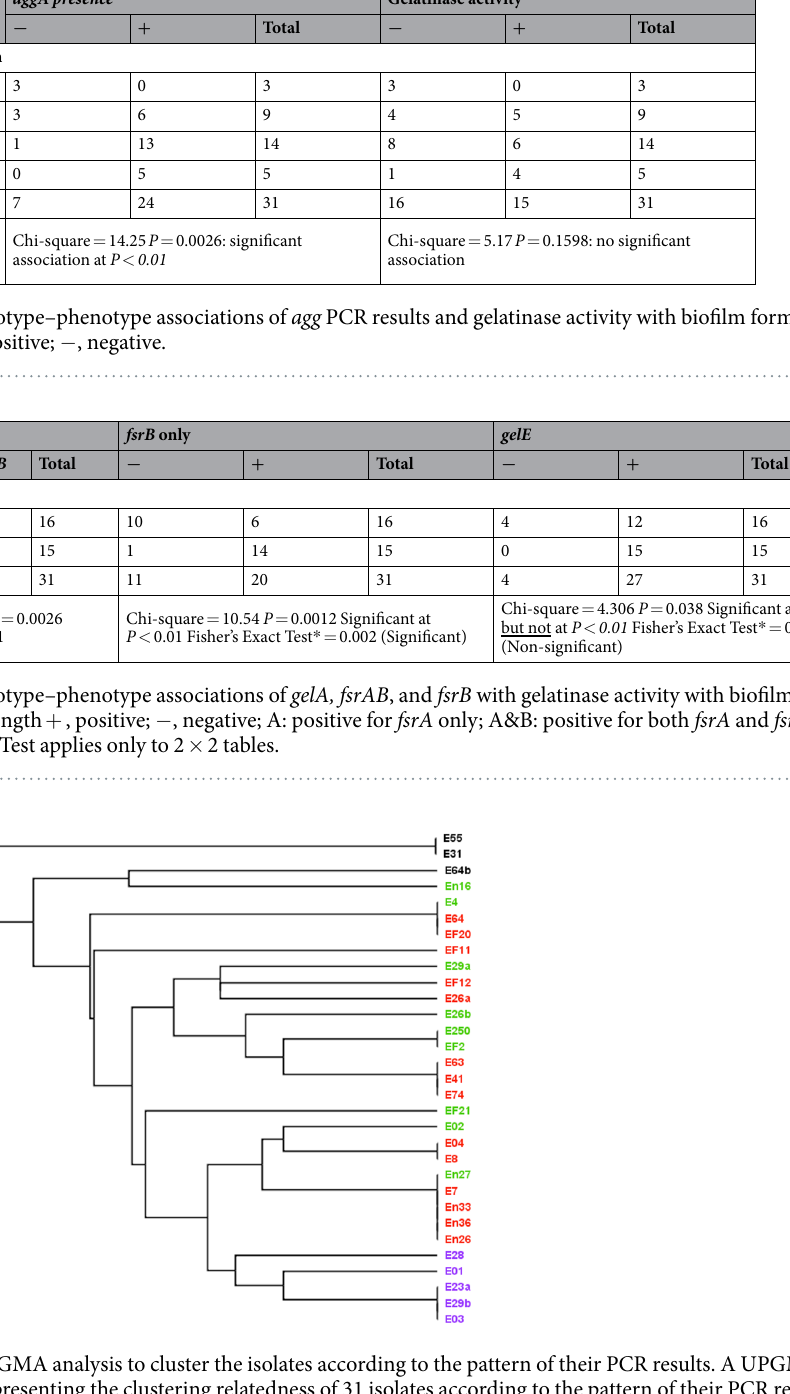
Antibiotic resistance pattern and effect of antibiotic sub-MIC on biofilm formation. The sen- sitivity of the isolates to azithromycin, ciprofloxacin, vancomycin, gentamycin and tigecycline was estimated by the determination of MIC values by the broth microdilution method. MICs of vancomycin was ≤ 4 µ g/ml, tigecy- The strains selected for subsequent assays were those with strong biofilm-forming phenotype, which were also gelatinase positive. The five isolates with strong biofilm formation ability were sensitive to vancomycin and tigecycline (Fig. 5). Both antibiotics were tested for their sub-MIC effect on the adherence of the five isolates. In